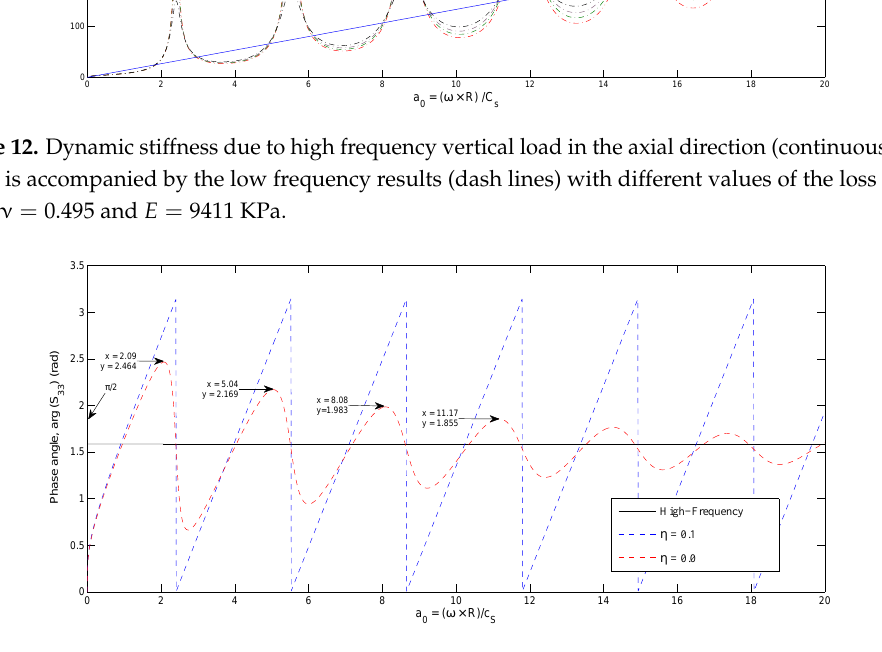
Figure 13. Phase angle of dynamic stiffness due to high frequency vertical load in the axial direction, which is accompanied by the low frequency results with different values of the loss factor when ν = 0.495 and E = 9411 KPa.